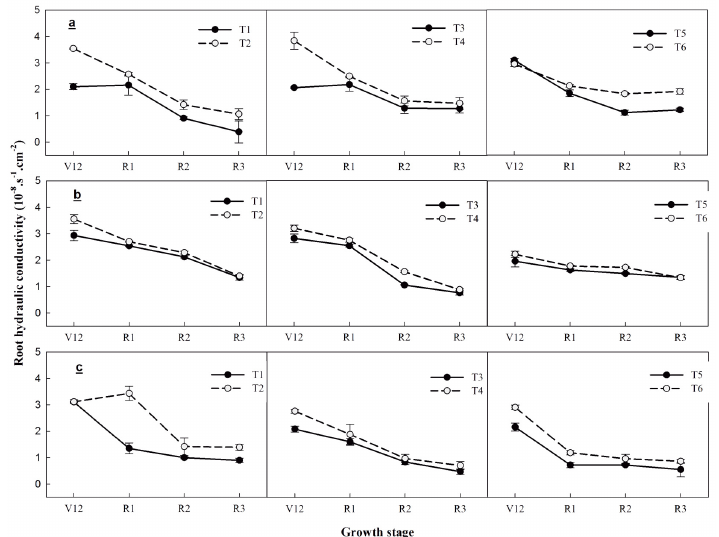
Figure 5. Lpr changes under organic manure in different planting stages . In this figure, V12, R1, R2 and R3 are different growth stages. V12 means the stage when the first leaf and second leaf are visible, R1 means that a silk is visible, R2 means that silks have darkened and are beginning to dry out, R3 means the silks have dried out. Letter ( a ) means the year 2011, ( b ) means the year 2012 and ( c ) means the year 2013.